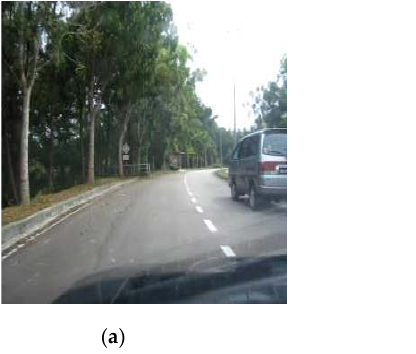
( c ) Figure 19. Autonomous detection and navigation of the proposed system in the road following (with 5 m as width and 500 m as length) with a car on the side/in front: ( a ) original image, ( b ) image processing, and ( c ) generation of the path within the road following environment. ( a )